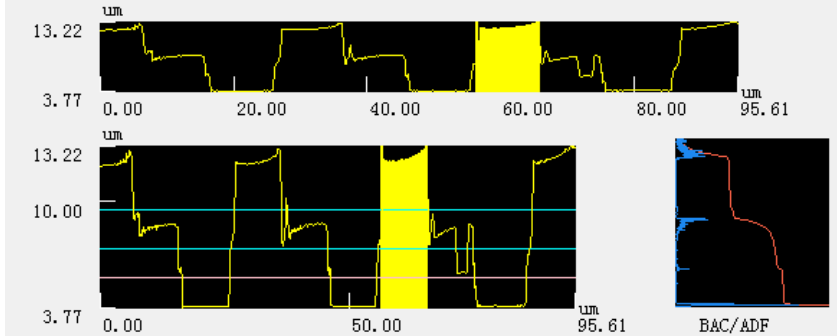
Figure 7. Enlarged view of the area-A.